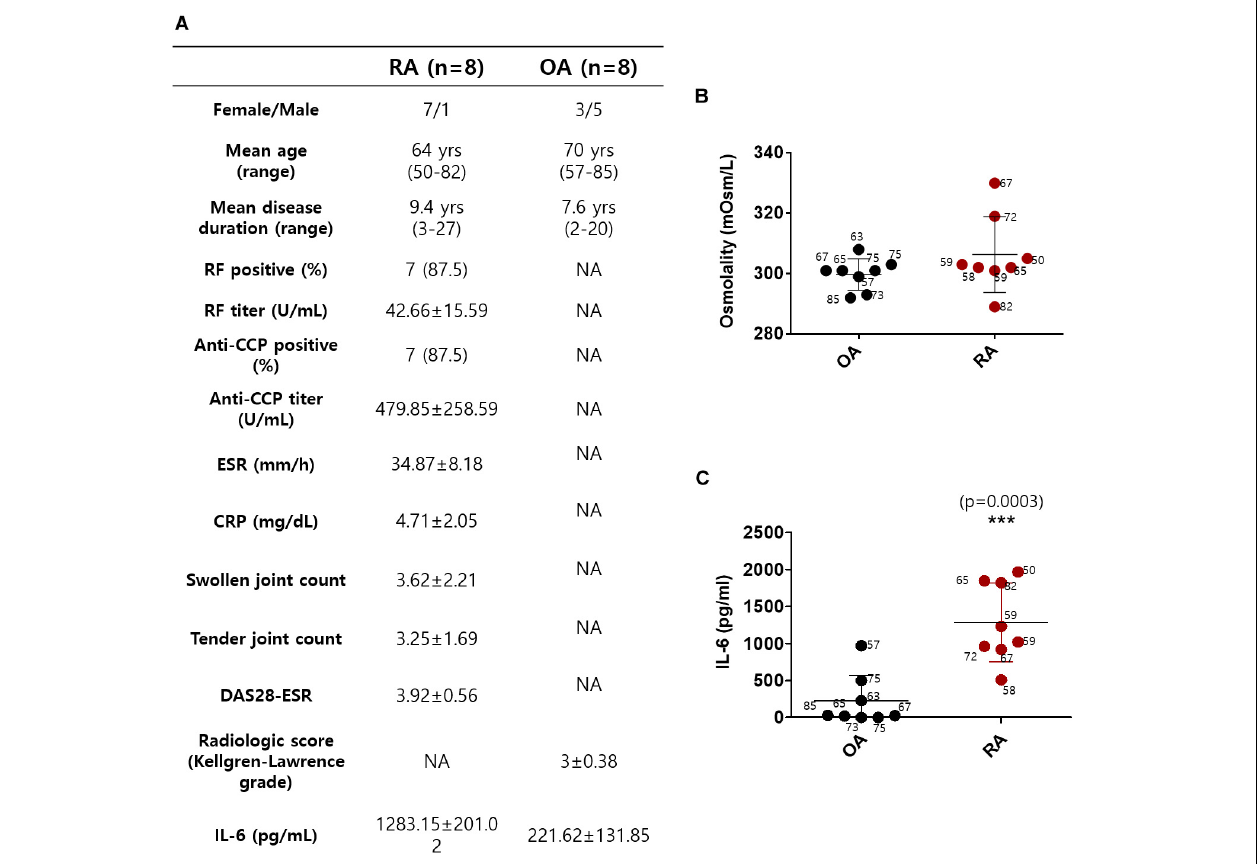
FIGURE 1 | Synovial fluid interleukin (IL)-6 level was enhanced in rheumatoid arthritis (RA) patients compared to osteoarthritis (OA) patients. (A) Demographic data of RA patients and OA patients. (B) Osmolarity (mOsm/L) of synovial fluids in OA and RA patients. (C) Measurement of IL-6 levels in synovial fluids of OA and RA patients using ELISA assay ( n = 8, *** p < 0.001, *: OA vs